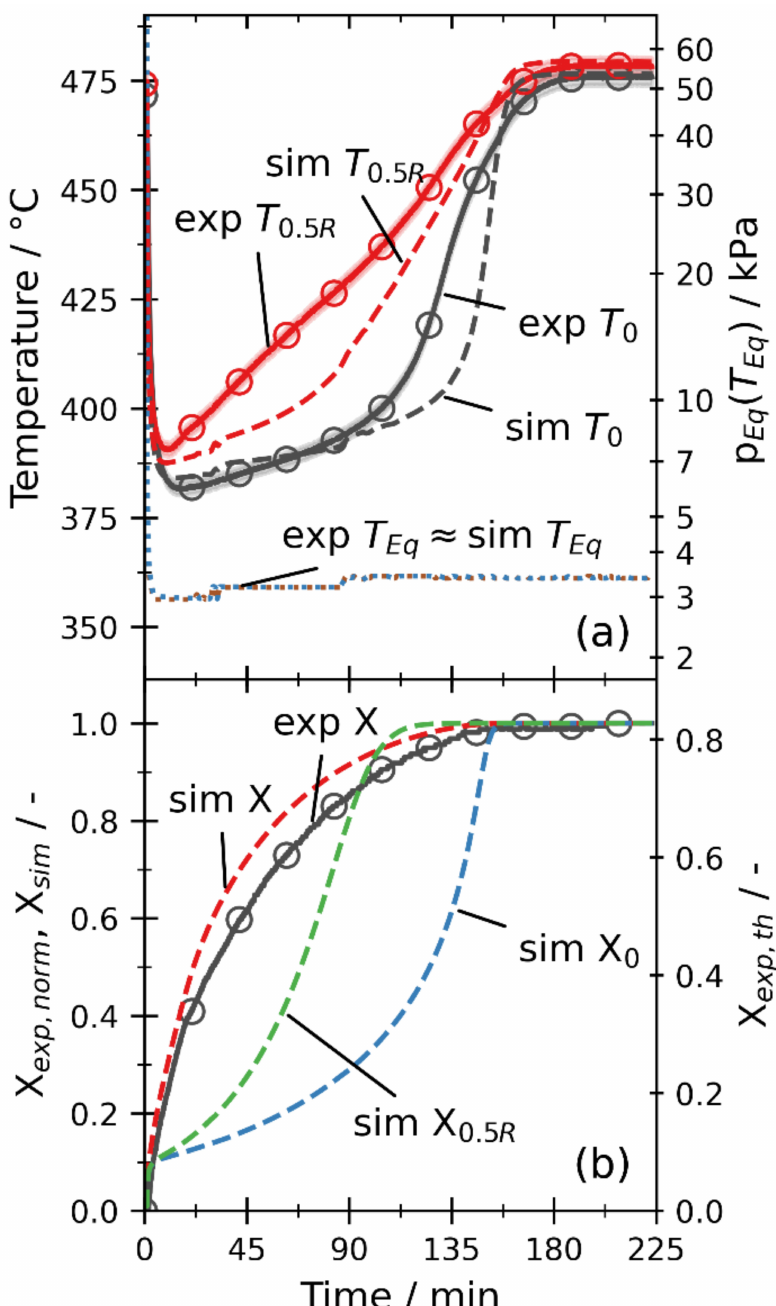
Figure 8. Comparison of the experimental and numerical results of temperatures ( a ) and conversions ( b ) for E15. The pressure is reduced to 3.5 kPa, and heaters are set to 490 ◦ C. In the simulation, an enhanced permeability by the factor 100 is used. The MAEs amount to 6 K, 8.2 K, and 0.04 for T 0 , T 0.5R , and the conversion,